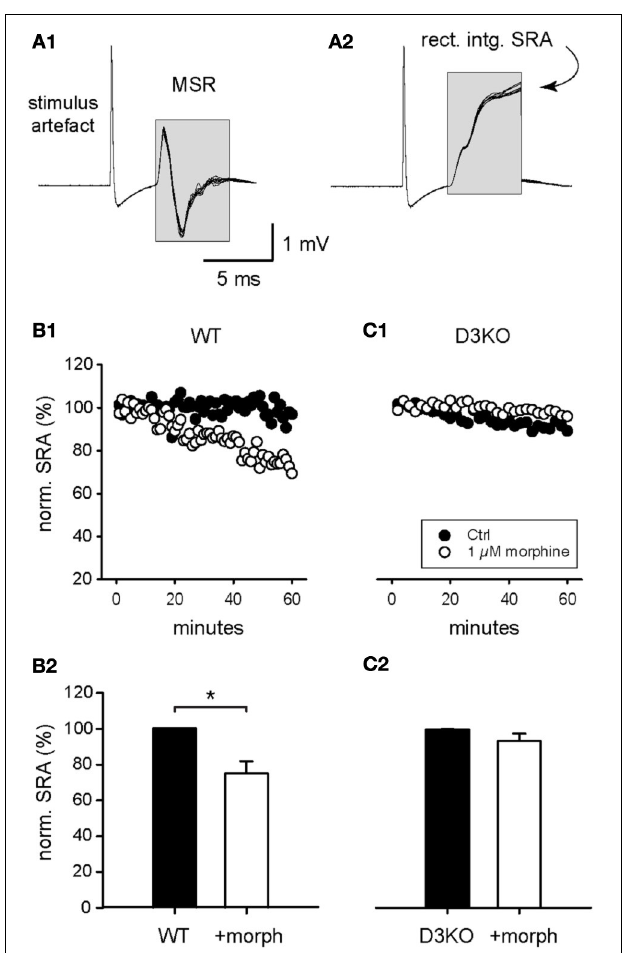
FIGURE 3 | Modulation of spinal reflex amplitudes (SRAs) by morphine. (A1) Example of a reflex response recorded from ventral roots (10 consecutive sweeps superimposed). Stimulation of a dorsal root (at stimulus artifact) induced a monosynaptic reflex response (MSR) in the corresponding ventral root. The boxed region identifies the epochs chosen to calculate the amplitude of the spinal reflex amplitude (SRA) represented in (A2) . (A2) The rectification and subsequent integration of the epochs identified in (A1) led to the signal values highlighted in the boxed region. The final maximal values of each epoch were used as a measurement of the SRA for each sweep, and used in the subsequent analysis steps represented in panels (B,C) , and Figures 4 , 5 . (B1) Typical time course of control SRAs in WT before and during bath-application of 1 μ M morphine (control: black symbols; morphine: white symbols). During morphine, reflex amplitudes gradually decreased in amplitude. (B2) Normalized SRAs in WT ( n = 6). Morphine led to a significant reduction in SRA. ∗ p = 0 . 004. (C1) Typical time course of control SRAs in D3KO before and during bath-application of 1 μ M morphine (control: black symbols; morphine: white symbols). (C2) Normalized SRAs in D3KO ( n = 12). In these animals, morphine had no significant effect on SRA.